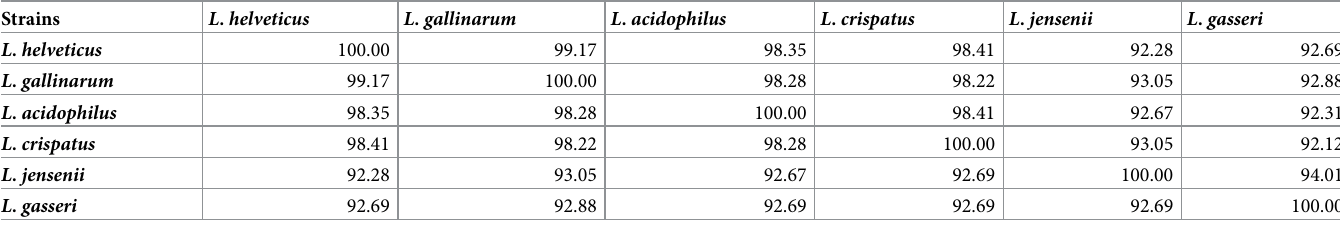
All strains are type strains; L . helveticus ATCC 15009, L . gallinarum ATCC 33199, L . acidophilus ATCC 4356, L . crispatus ATCC 33820, L . jensenii ATCC 25258, L. gasseri ATCC 33323. Each numbers indicated sequence identity percentage.